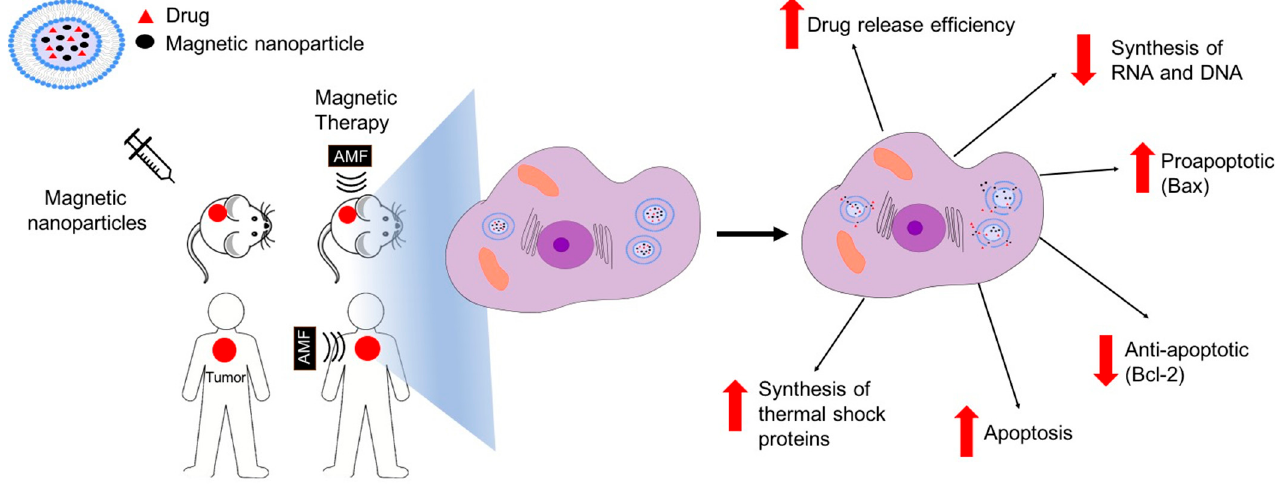
Figure 6. Synergism between magnetic therapy and chemotherapy. The presence of magnetolipo- somes enables increased temperatures in local tissues to increase the effect of antitumor drugs and increase apoptosis. There are several mechanisms by which magnetic hyperthermy could act synergically with chemotherapy on tumor cells. Hyperthermia could cause changes in the fluidity and stability of the cell membrane. It also could induce the synthesis of thermal shock proteins, cause damage in the synthesis of RNA and DNA, increase drug release, and alter apoptosis resistance proteins, leading to an increase in apoptosis. Despite significant efforts having been made in the in vitro and in vivo studies of magnetoliposomes, clinical trials have not yet been performed.